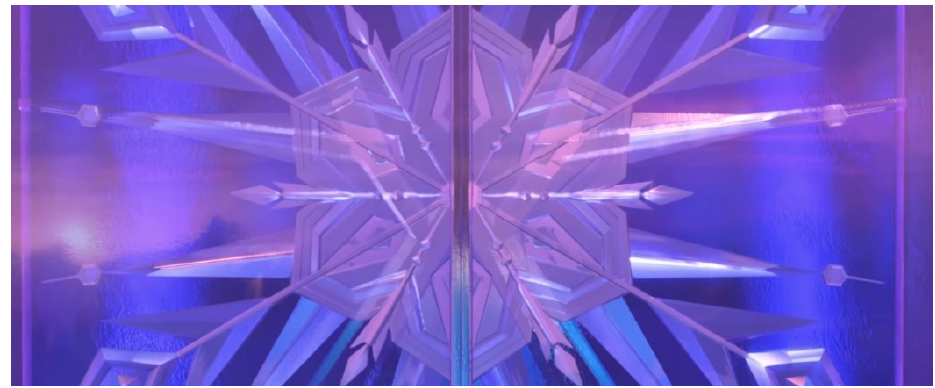
Figure 8. The door of the Ice Palace is shut.